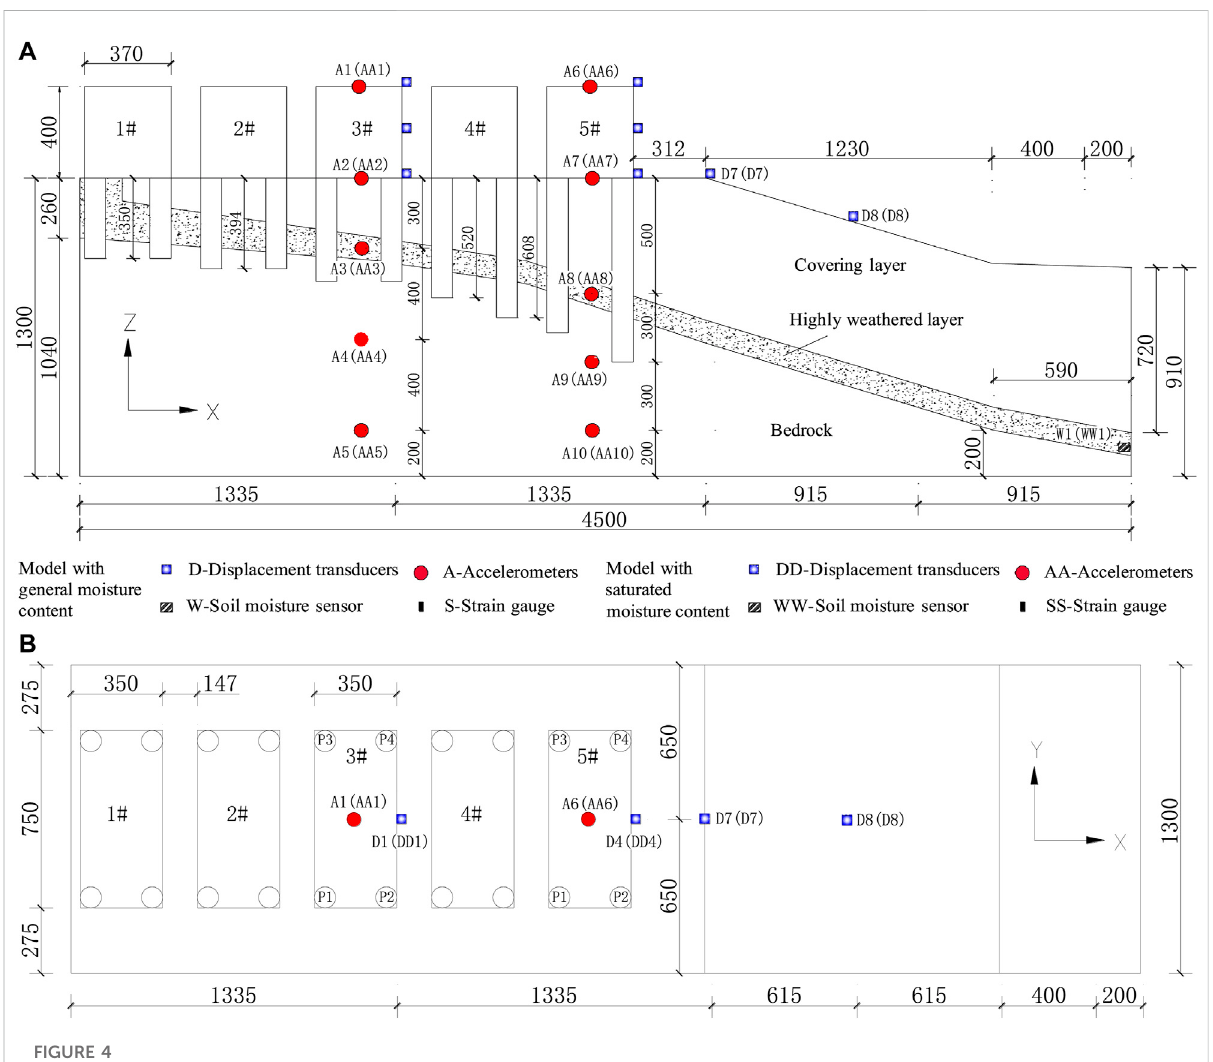
FIGURE 4 Schematic of the model: (A) pro fi le map; (B) pop view (unit: